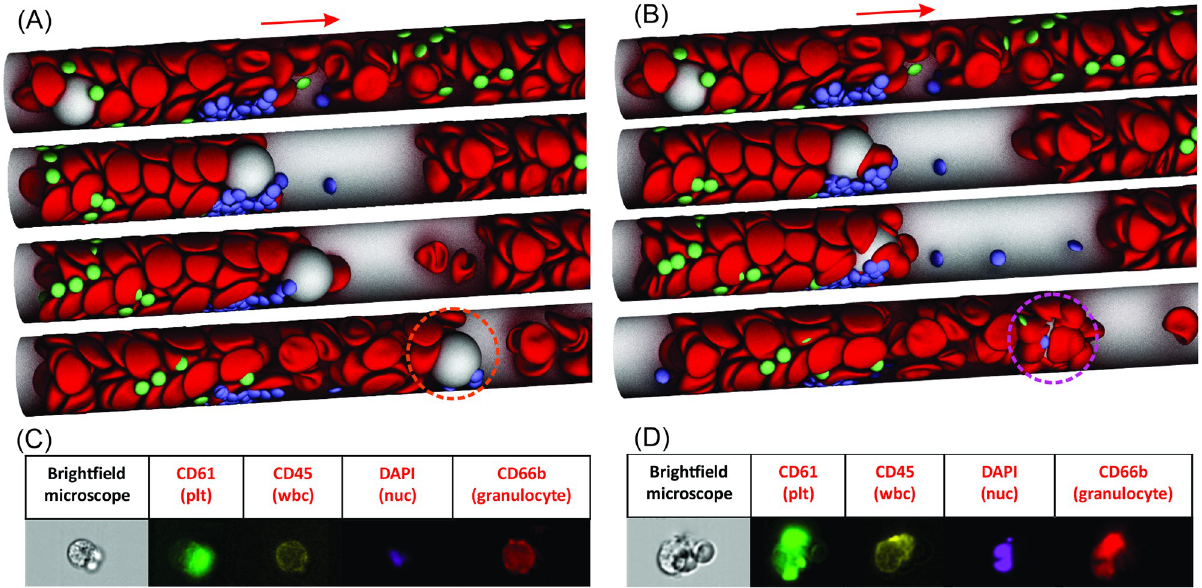
Fig 6. Interaction of a flowing WBC with existing thrombus. (A) Four sequential snapshots illustrate that at an initial blood flow velocity of 0.38 mm/ s, a flowing WBC first attaches to an existing thrombus at the thrombogenic site and subsequently detaches from the thrombus, forming a WBC-platelet cluster (highlighted by an orange dotted circle) when WBC-RBC adhesion is not considered. See S4 Movie. (B) Under the same flow condition, the flowing WBC adheres to the surrounding platelets and RBCs during its interaction with the thrombus when WBC-RBC adhesion is considered, forming a WBC-RBC-platelet aggregate (highlighted by a magenta dotted circle). See S5 Movie. Blood flows from left to right. Flow cytometry images with staining of CD61, CD45, DAPI and CD66b show (C) a WBC-platelet cluster and (D) a WBC-platelet-RBC cluster from blood samples of patients with COVID-19